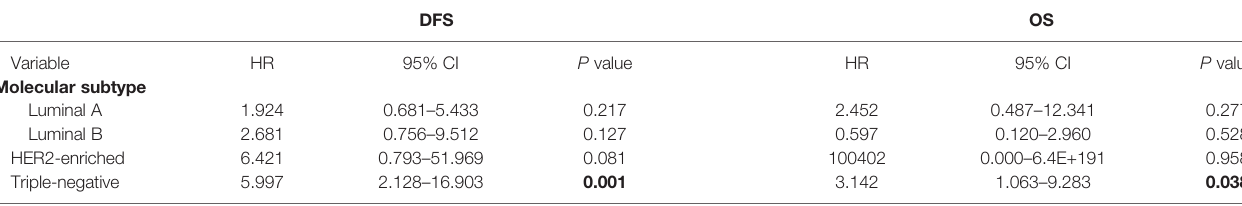
CI, con fi dence interval; HR, hazard ratio; DFS, disease-free survival; OS, overall survival. The covariates in the Cox model included miR-223 and TNM stage. The adjusted p value and HR were derived from the Cox model; miR-223 = 1 was used as a reference. The p value of multivariate cox regression analysis for miR-223 in TNBC subtype is marked